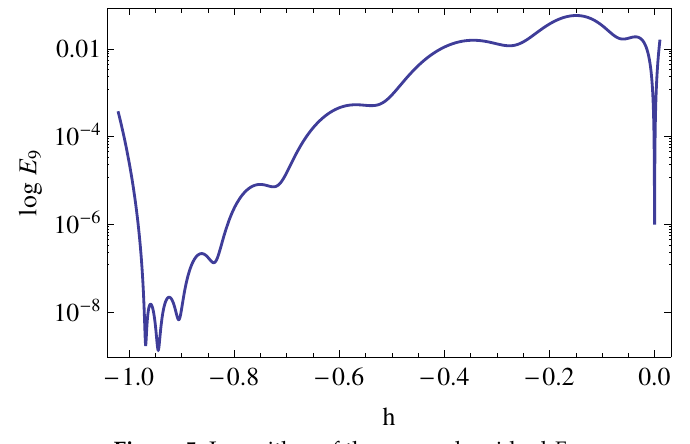
Figure 5. Logarithm of the squared residual E 9 . Table 2. Values of errors of the exact solution reconstruction ( ∆ n ).